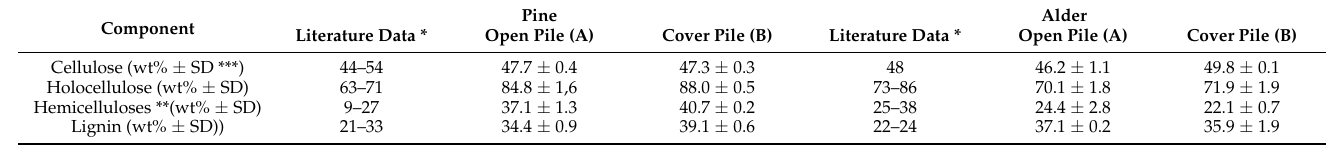
Table 1. Composition of pine and alder wood kept in the open and cover pile. Pine Alder Component Literature Data